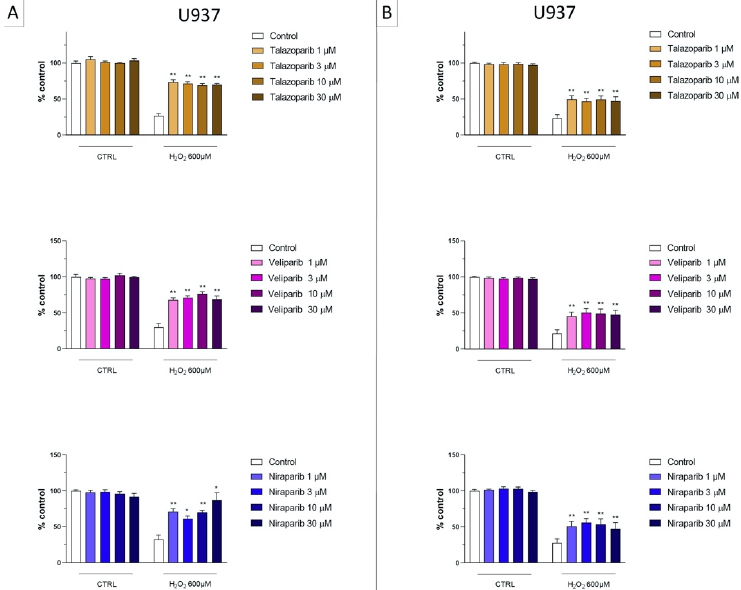
Figure 4. Effect of the clinical-stage PARP inhibitors talazoparib, veliparib, or niraparib on H 2 O 2 - induced suppression of cellular MTT-converting activity in U937 cells. Cells were treated for 2 h ( A ) or 24 h ( B ) with 600 µM H 2 O 2 ; the PARP inhibitors were applied at different concentrations (1, 3, 10, and 30 µM). * p < 0.05 and ** p < 0.01 indicate the beneficial effect of PARP inhibition to counteract the effect of oxidative stress. Data are shown as mean ± SEM of n = 5 independent experiments.